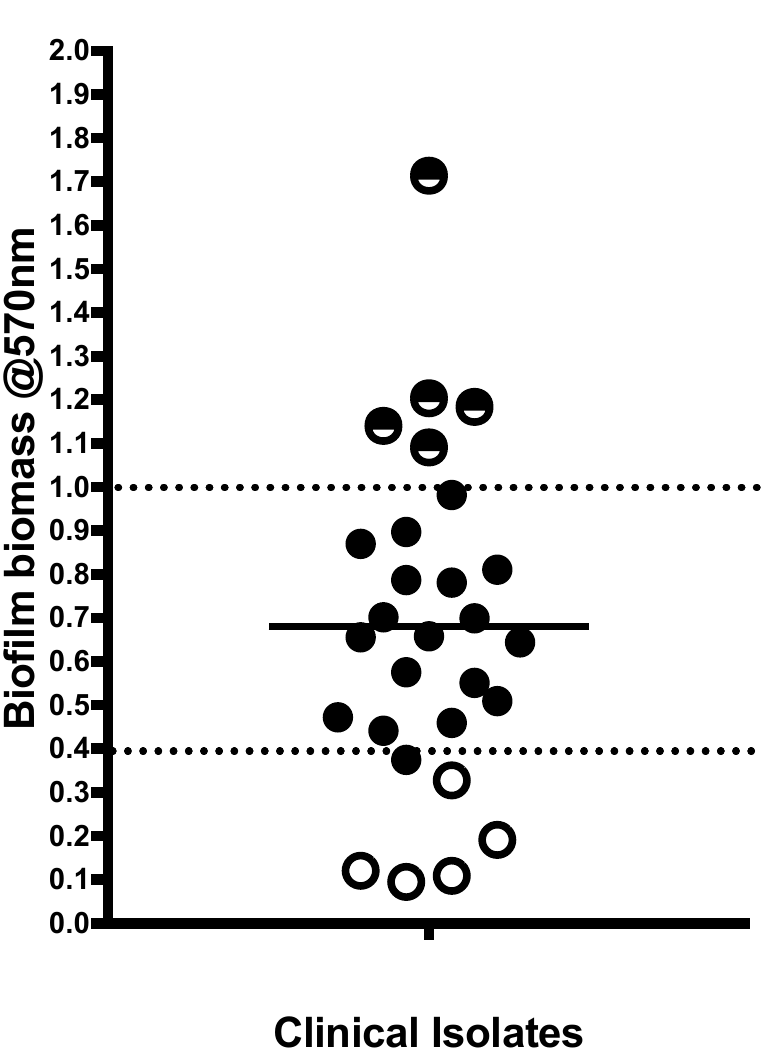
Figure 1. Quantification of biofilm biomass from clinical isolates. low biofilm forming (LBF) and high biofilm forming (HBF) identified by horizontal lower and higher dotted lines. Those isolates with an open circle or half dark / white circle represent the five LBF and HBF isolates selected for downstream Figure 2 analysis, respectively.